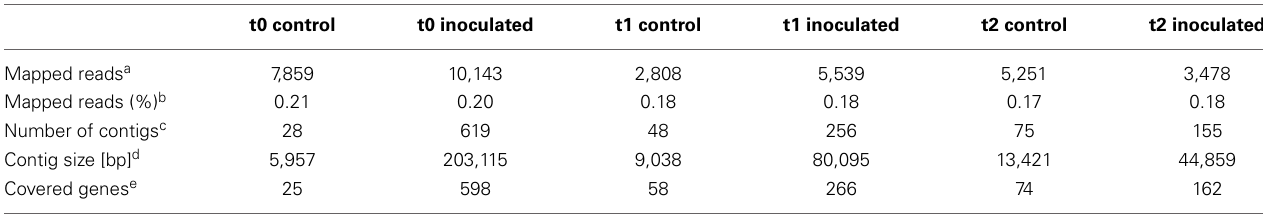
Table 2 | Mapping of reads, contigs and genes from the metagenome datasets to the B. amyloliquefaciens FZB42 reference genome. t0 control t0 inoculated t1